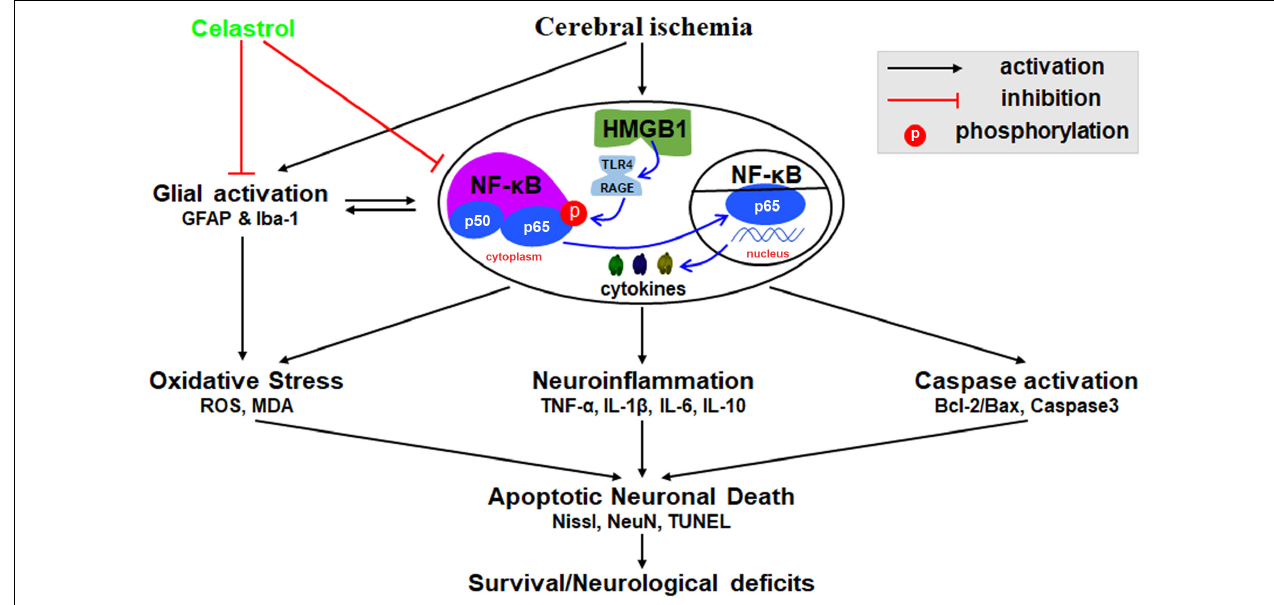
FIGURE 8 | Schematic diagram illustrating possible neuroprotective mechanisms of celastrol against glial activation, oxidative stress and neuroinflammation in tGCI/R rats via the high mobility group box 1 (HMGB1) and Toll-like receptor 4 (TLR4) /nuclear factor (NF- κ B) pathway. Cerebral ischemia induced HMGB1 nuclear-cytoplasmic translocation and activate TLR4/RAGE, promote the phosphorylation of I κ B α , thus inducing the translocation of NF- κ B from the cytoplasm to the nucleus, promote gene expression and generate a series of cytokines, thus promoting glial activation, neuroinflammation, oxidative stress, and caspase activation, eventually lead to apoptotic neuronal death. GFAP, glial fibrillary acid protein; Iba-1, ionized calcium binding adaptor molecular 1; ROS, reactive oxygen species; MDA, malondialdehyde; TNF- α , tumor necrosis factor α ; IL- β , interleukin- β ; IL-6, interleukin-6; IL-10, interleukin-10.